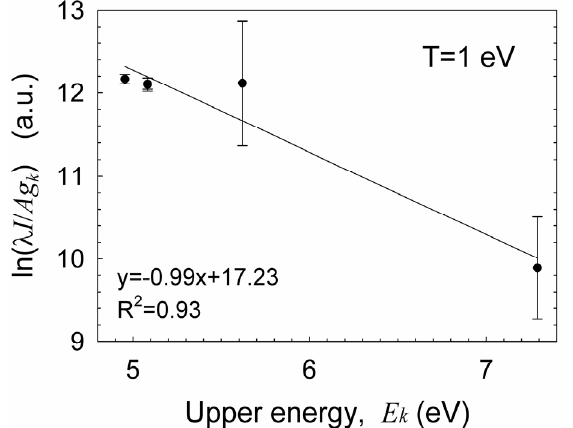
Figure 6. A Boltzmann plot of the silicon lines resulting in a ~1 eV excitation